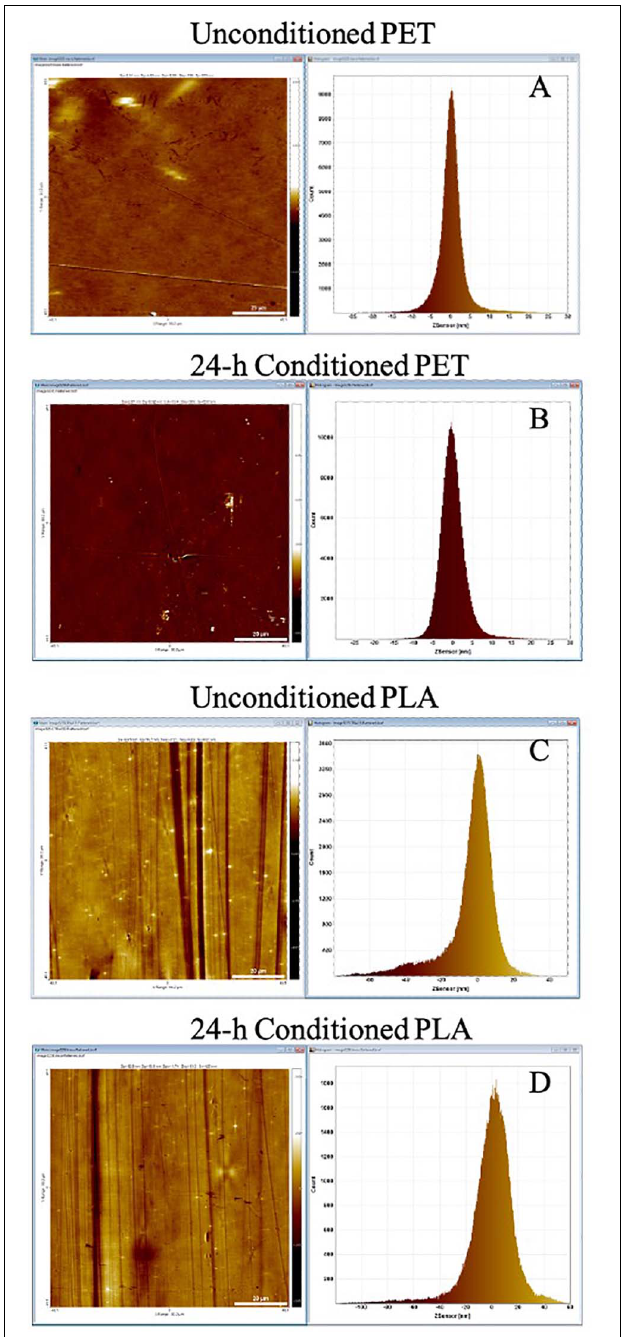
FIGURE 2 | AFM topography image and pixel height histogram of the (A) unconditioned PET surface, (B) PET surface following exposure to seawater for 24 h, (C) unconditioned PLA surface, (D) PLA surface following exposure to seawater for 24 h. The standard deviation of the pixel height distribution is equivalent to the RMS roughness ( S q ) of the